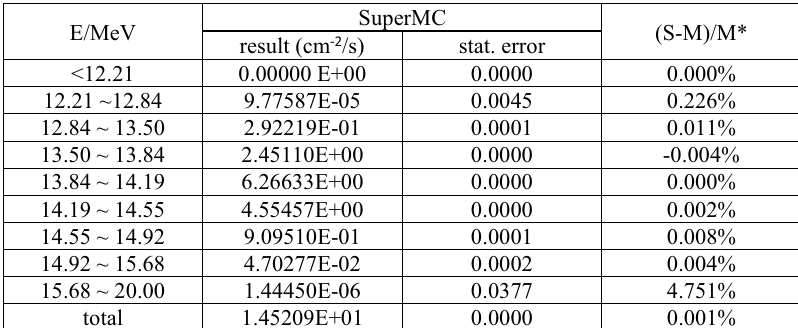
Table I. Spectra of neutron flux at plasma source cell